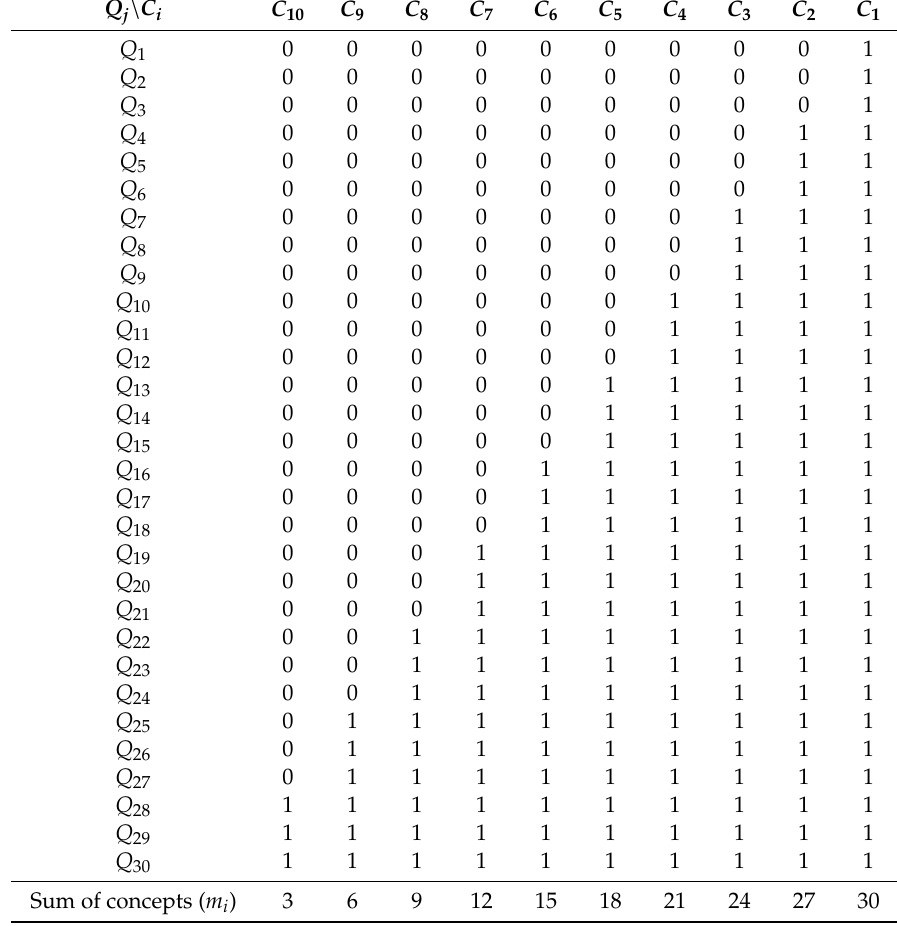
Table 7. Codes for test questions ( Q j ) and concepts ( C i ) in each skill level for the area computation unit.